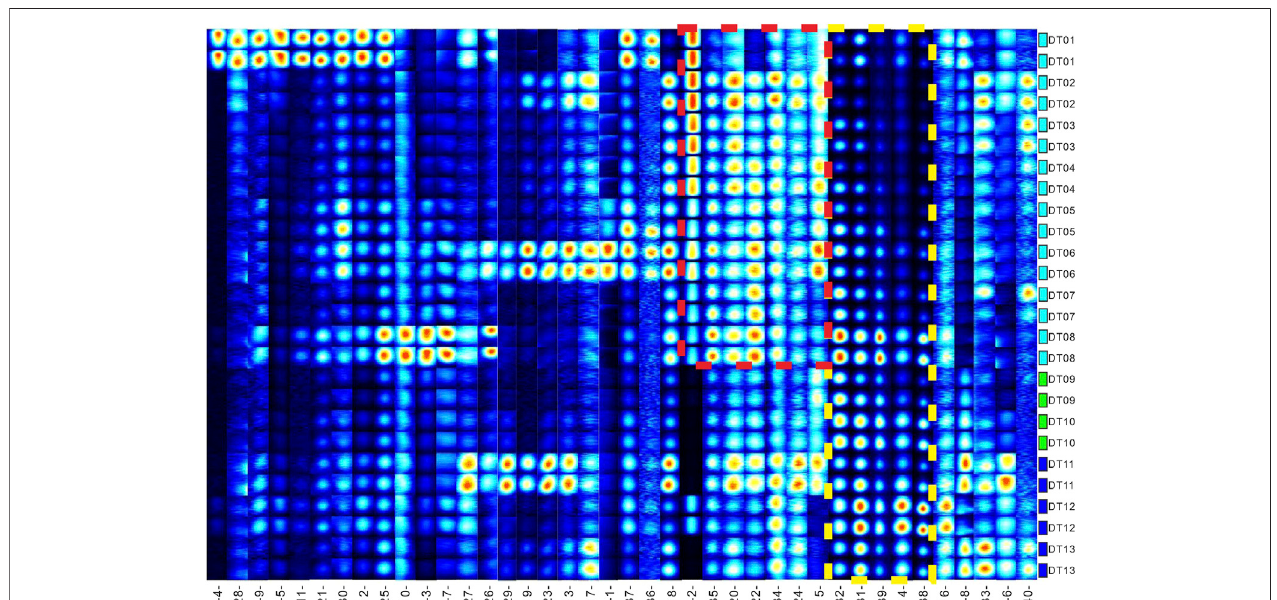
FIGURE 4 | Fingerprints of different sample types in the gallery